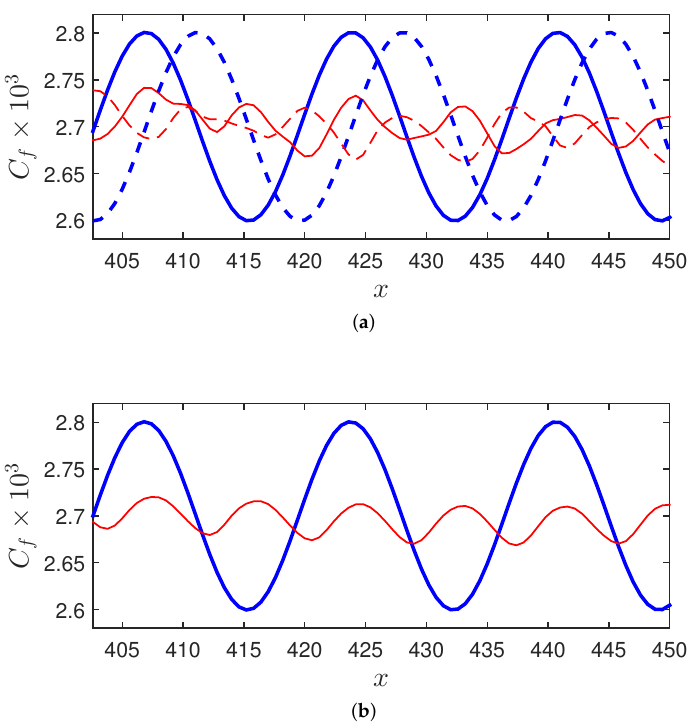
Figure 4. ( a ) Skin friction coefficient (red) together with (scaled) wall velocity (blue) at two different phases. (Solid lines) φ = 0 ◦ ; (broken lines) φ = 90 ◦ . ( b ) Skin friction coefficient (red) together with (scaled) wall velocity (blue) with all phases added together, taking into account spatial phase shift. Wall velocity is scaled to fit graph according to formula W /6 +